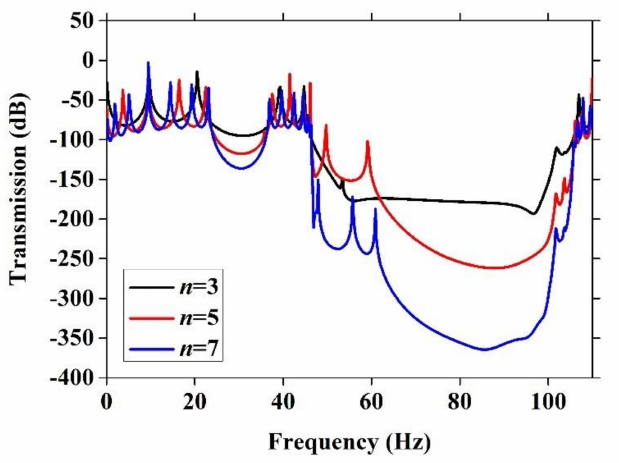
Figure 16. The transmission response curves with di ff erent period number n .